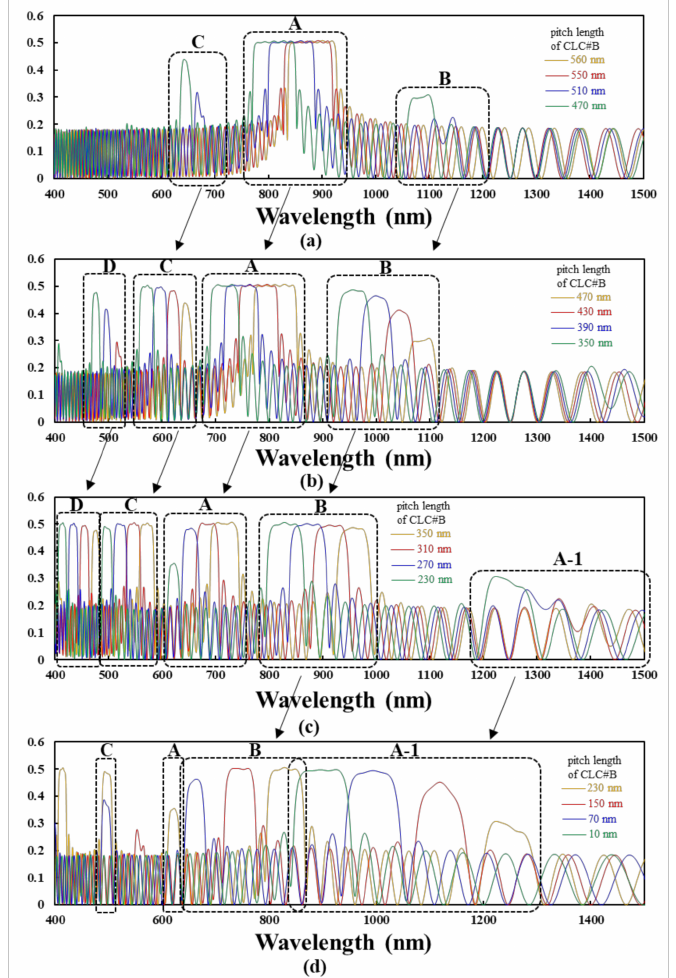
Figure 2. Simulation results of the reflection spectra of BLCPFs realized by fixing the pitch length of CLC#A at 560 nm and by decreasing the pitch length of CLC#B from ( a ) 560 [yellow curve], to 550 [red curve], 510 [blue curve], and 470 [green curve] nm; ( b ) 470 [yellow curve], to 430 [red curve], 390 [blue curve], and 350 [green curve] nm; ( c ) 350 [yellow curve], to 310 [red curve], 270 [blue curve], and 230 [green curve] nm; and, ( d ) 230 [yellow curve], to 150 [red curve], 70 [blue curve], and 10 [green curve]